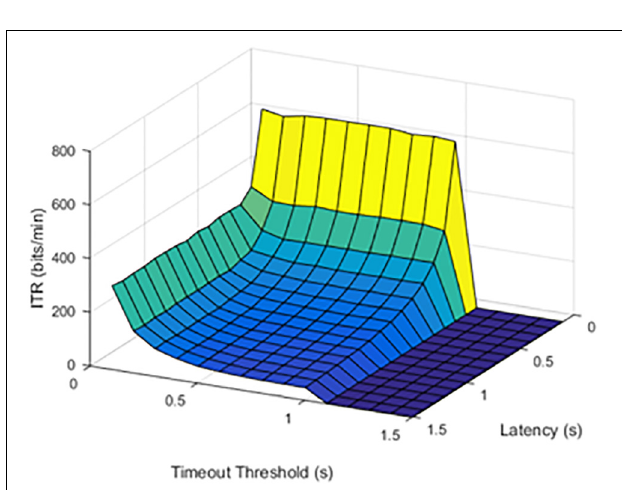
FIGURE 5 | Information transfer rate (ITR), chance of failure, and cutoff threshold at a latency of 1.0